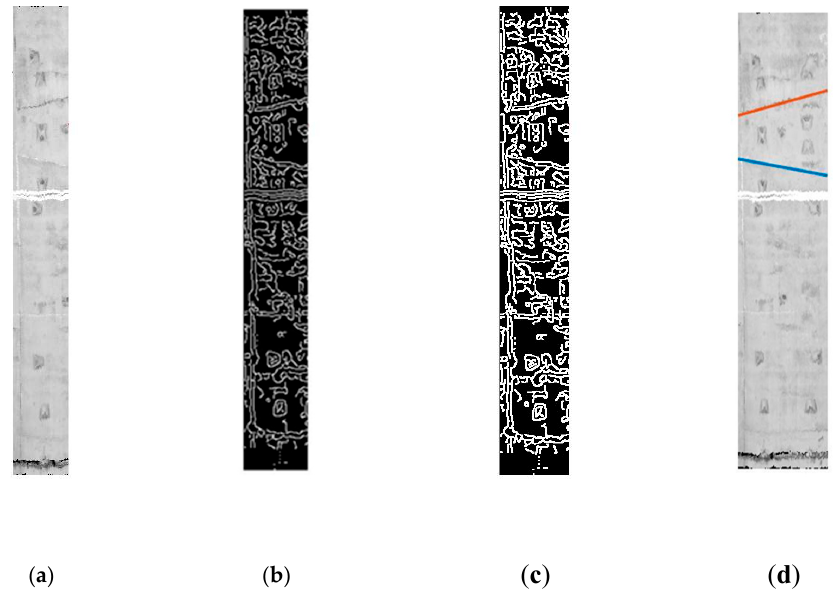
Figure 6. Seam recognition: ( a ) Segment orthophoto image, ( b ) Canny operator processed image, ( c ) Image after expansion processing, and ( d ) capping block test results.